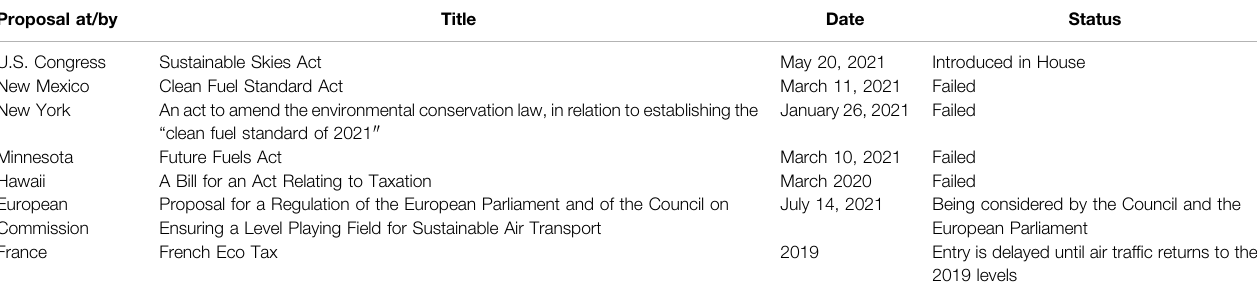
TABLE 2 | Example laws and regulations relating SAF that are pending or failed. (Sources: European Commission, 2021a; Burnett, 2021; New Mexico Environment Department, 2021; Argus Media, 2021; Orenstein, 2021.) Proposal